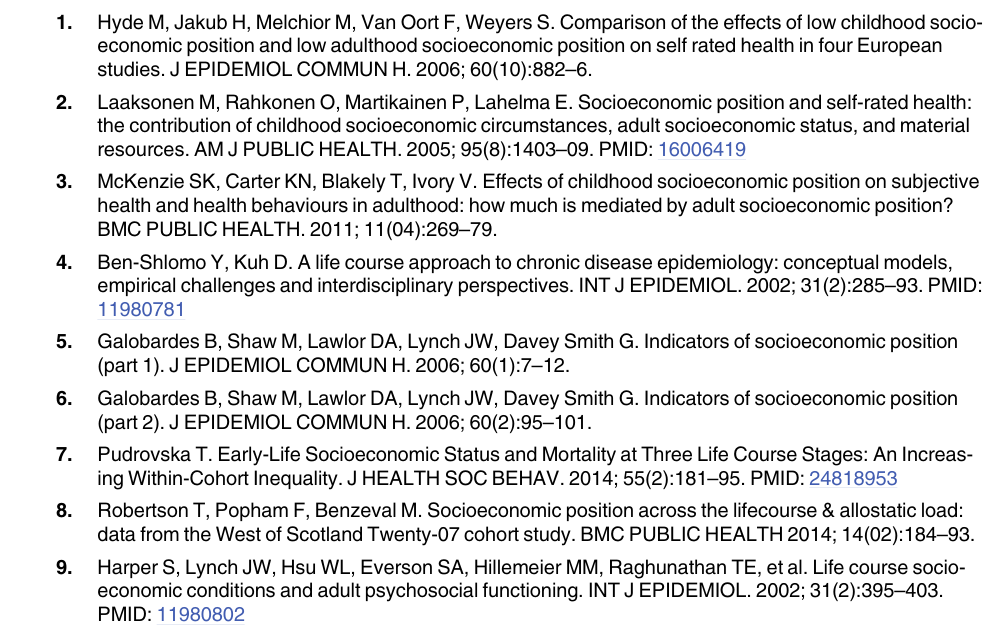
S1 Table. Pearson ’ s correlations between all the variables for women (above diagonal) and men (below diagonal); socioeconomic conditions (SC), occupational class (OC), material adversity (MA), social adversity (SA) and functional somatic symptoms (FSS) at four points in time — respondents aged 16, 21, 30 and 42. S2 Table. Direct and indirect effects in the model (5000 samples requested), stratified by sex (n = 473 women, 514 men). The variables are socioeconomic conditions (SC), occupa- tional class (OC), material adversity (MA), social adversity (SA) and functional somatic symp- toms (FSS), at four points in time — respondents aged 16, 21, 30 and